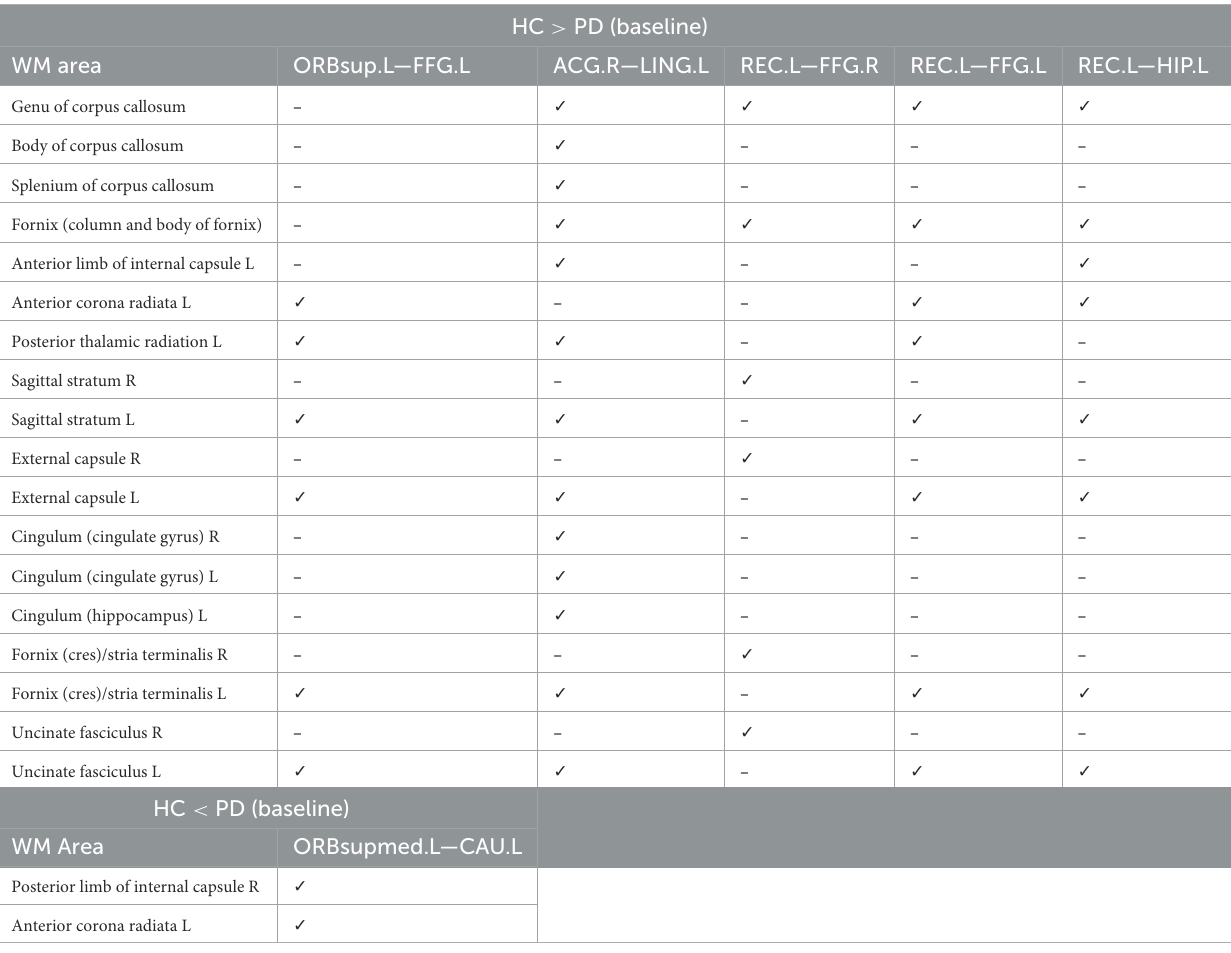
TABLE 2 WM areas where we found altered structural connectivity between HC and PD at baseline (cross-sectional analysis), as indicated by 3 .